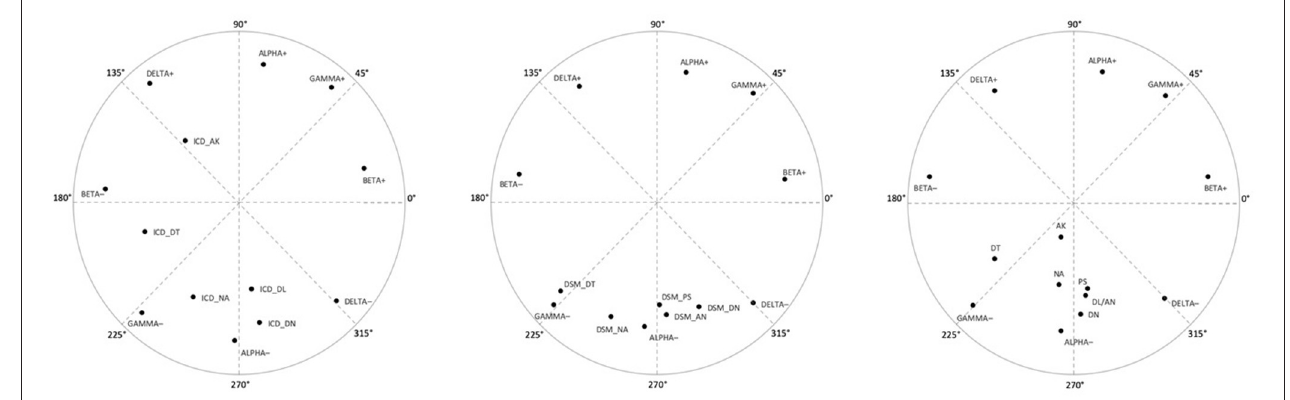
FIGURE 5 | Factor loading plots in Study 2 ( N = 355) for: (Analysis A) CPM metatraits and ICD-11 traits; (Analysis B) CPM metatraits and DSM-5 traits; and (Analysis C) CPM metatraits and the six-domain model traits (placed at left, middle, and right, respectively). NA, Negative Affectivity; DT, Detachment; DN, Disinhibition; DL, Dissociality; AN, Antagonism; AK, Anankastia; PS, Psychoticism; + denotes the positive pole of a metatrait; – denotes the negative pole of a